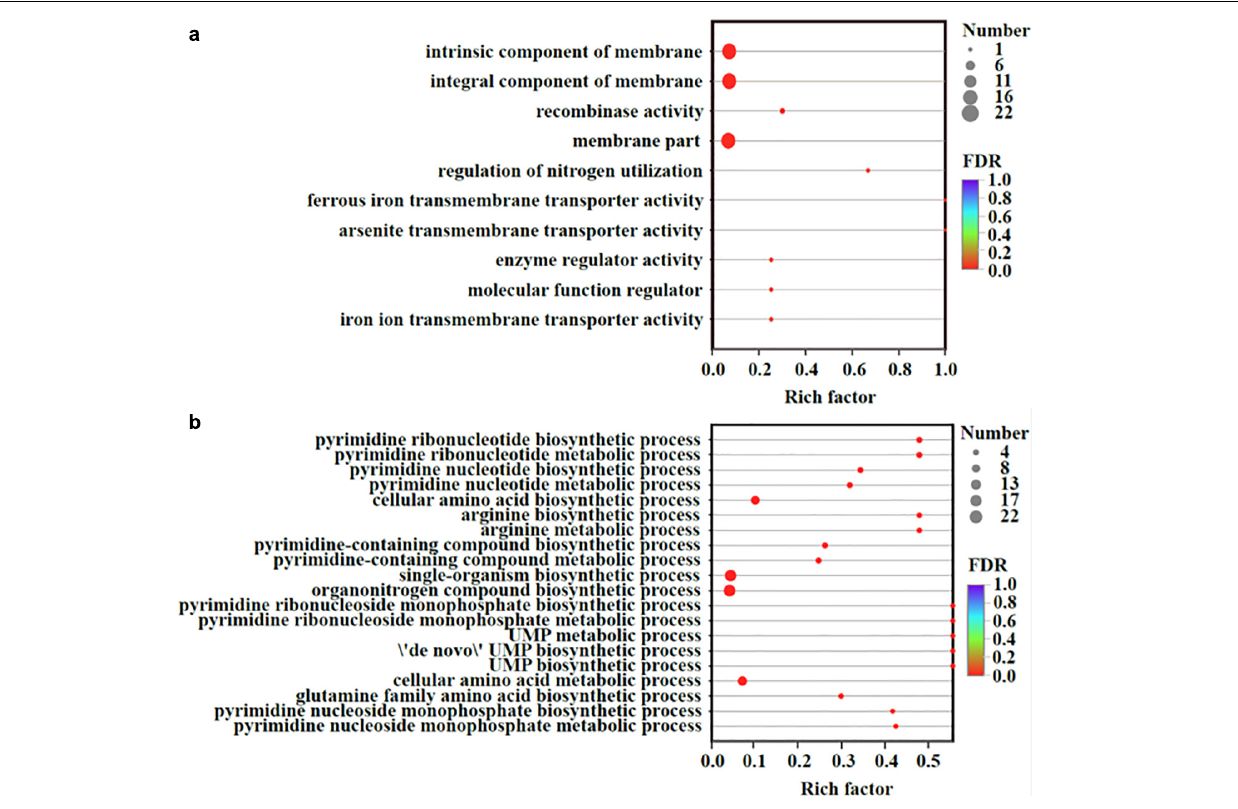
FIGURE 6 | Up-regulated (a) and down-regulated (b) genes organized by the GO enrichment analysis. Vertical axis represented the GO term; Horizontal axis represented the ratios of Sample number/Background number. The size of dots indicated the number of genes /transcripts in this GO term. All measurements were averages from three biological